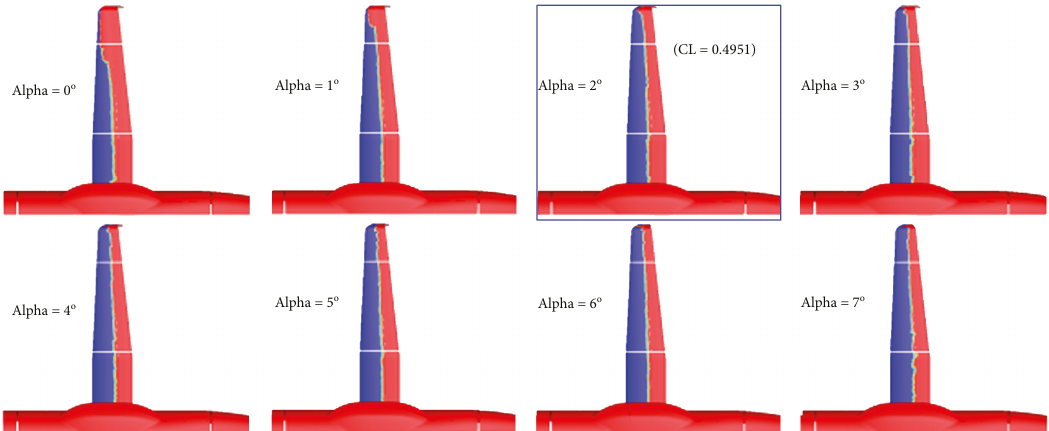
Figure 11: AG2-NLF plane: computed transition location on the wing lower surface at cruise conditions ( M = 0 52 @ 20000 ft). Blue=laminar, red =turbulent.